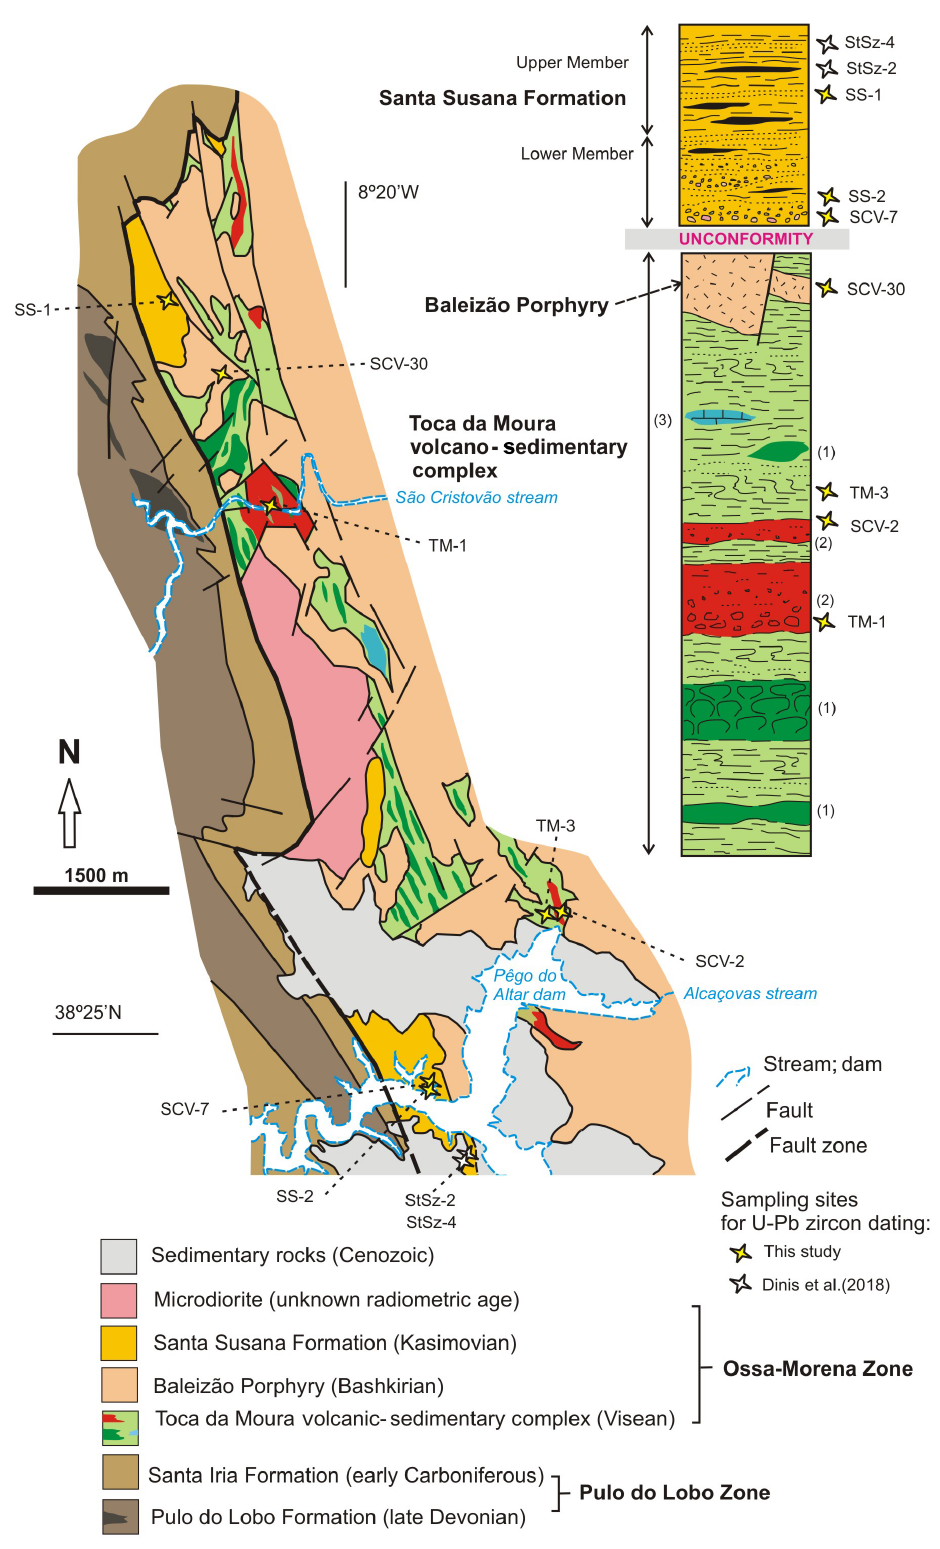
Figure 2. Simplified geological map and schematic stratigraphy of the Santa Susana–São Cristovão region (Ossa-Morena Zone; modified from Gonçalves and Carvalhosa, 1984; Machado et al., 2012). Sampling locations of the Carboniferous sedimentary and igneous rocks used for geochronology are indicated with yellow